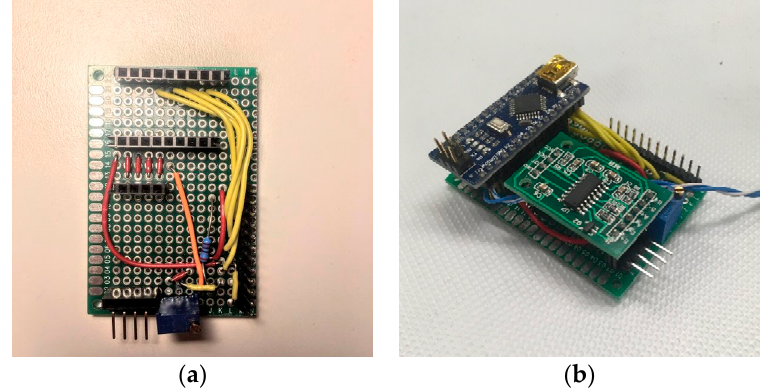
Figure 3. The circuit was assembled on a solder circuit board using jumper wires and header pins. The female header pins connect to the Arduino Nano and the HX711. The male header pins connect to the load cell and the LCD. The tare push-button is attached via twisted pair to allow installation on the face of the scale. ( a ) The soldered components were arranged in such a way to minimize wire use and to properly place the Arduino when installed in the base. ( b ) Shows the final circuit board.